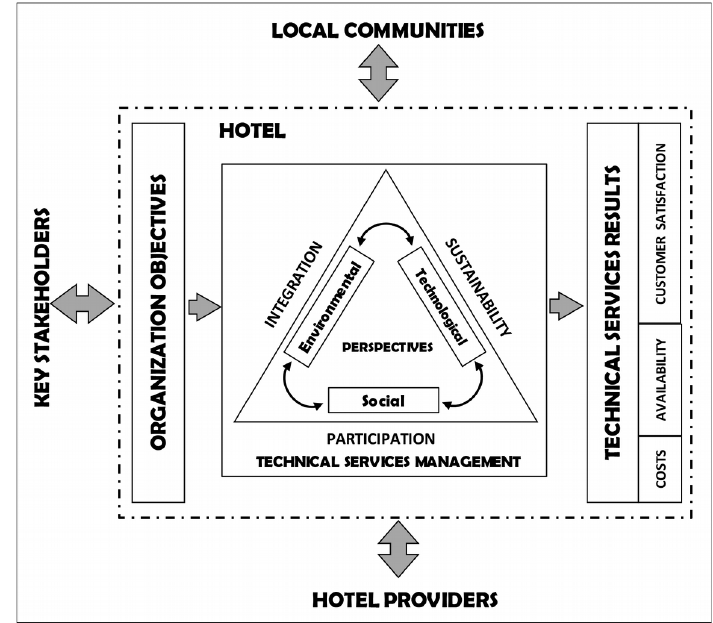
Figure 2. Theoretical model of the Technical Services management in sun and beach